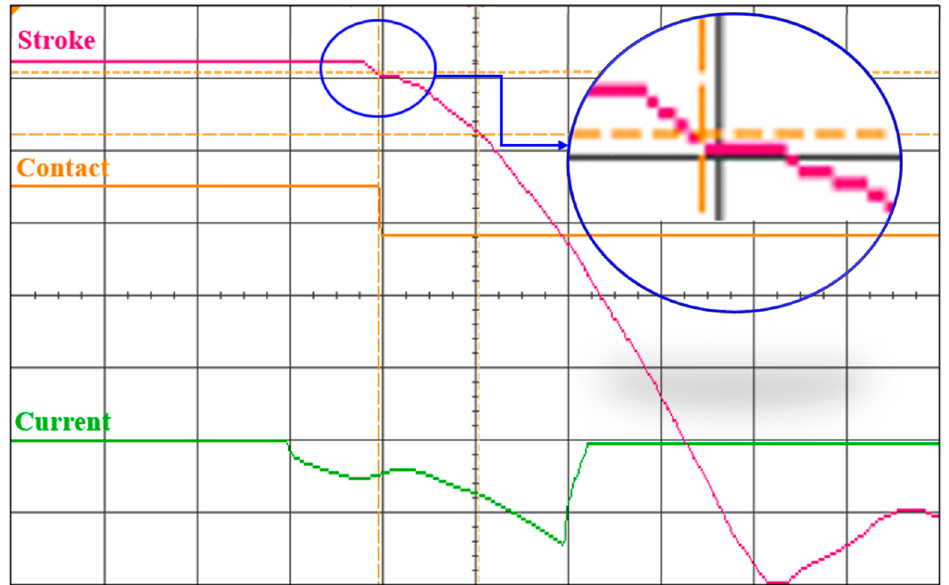
Figure 16. Characteristics of opening operation (interrupter moving part weighs more than actuator moving part).